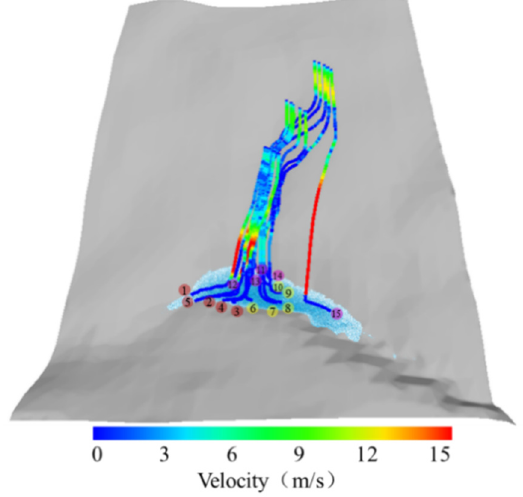
Figure 14. The trajectory of the monitored particles.